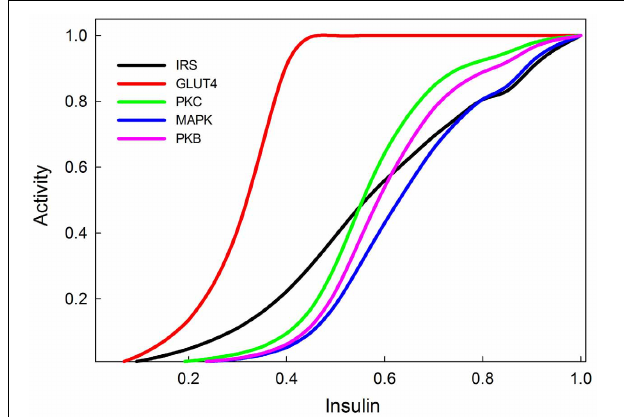
FIGURE 4 | MAPK cascade simulation shows that the signal becomes more switchlike as it travels down the MAPK cascade, as shown in Huang and Ferrell (1996).